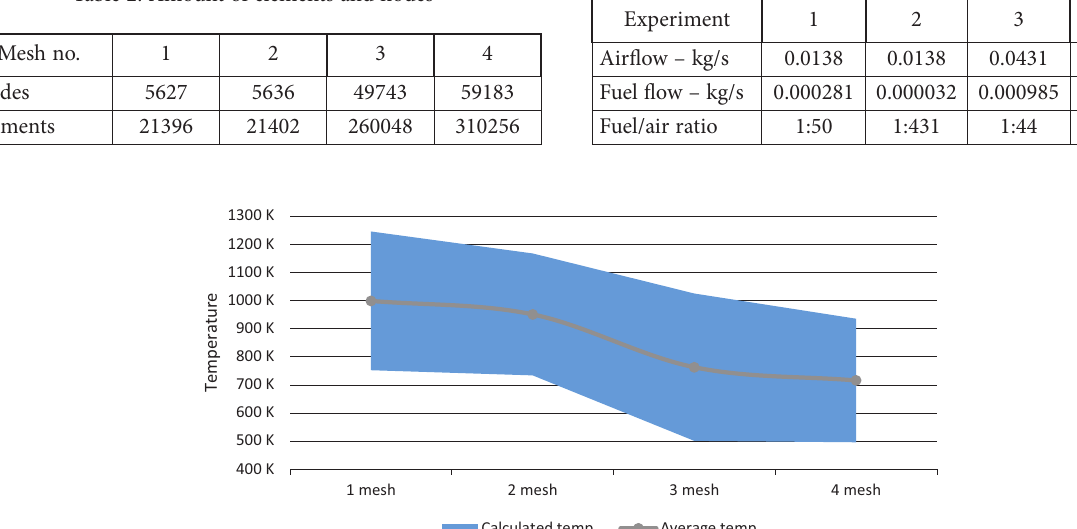
Calculated temp. Average temp. Figure 2. Mesh and temperature dependence using WGS reaction